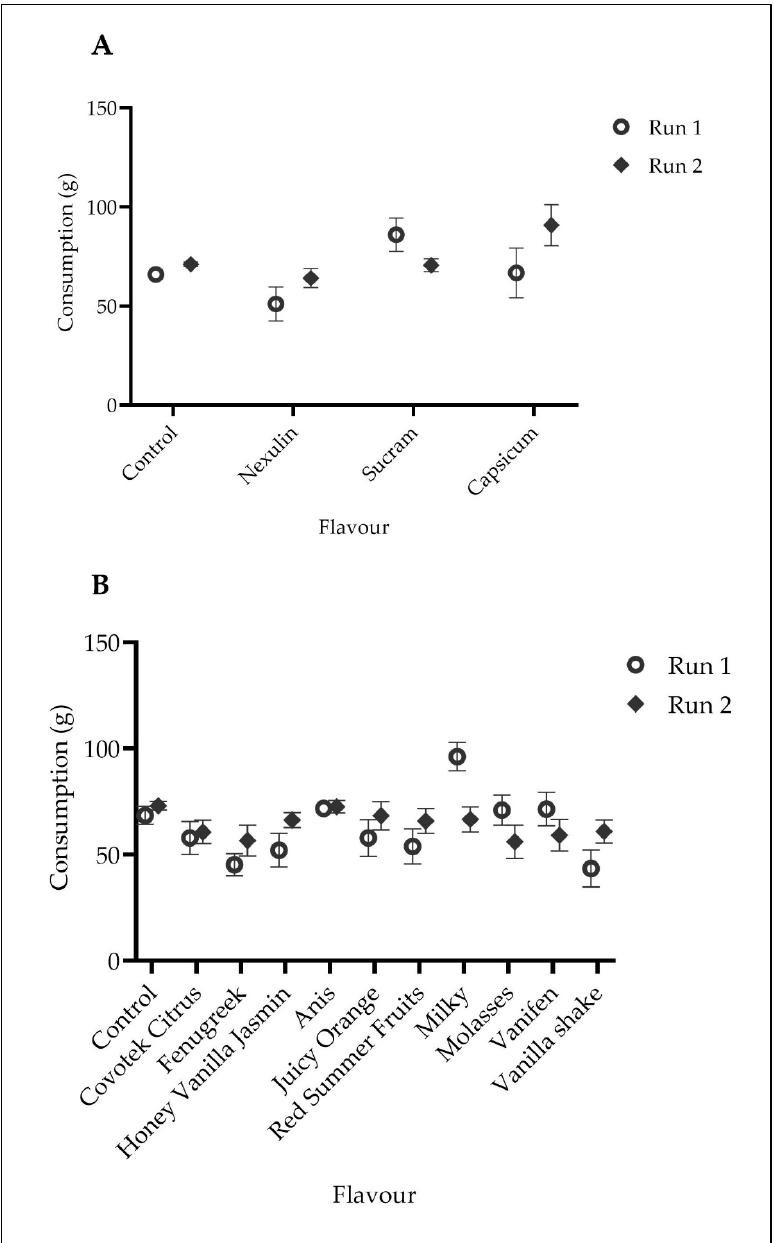
Figure 2. Consumption of the grain mixture flavoured with liquid non-aroma (( A ); p = 0.023) or powder-aroma flavours (( B ); p < 0.001) during the first (Run 1) or subsequent (Run 2) exposure presented as the mean ± standard error.